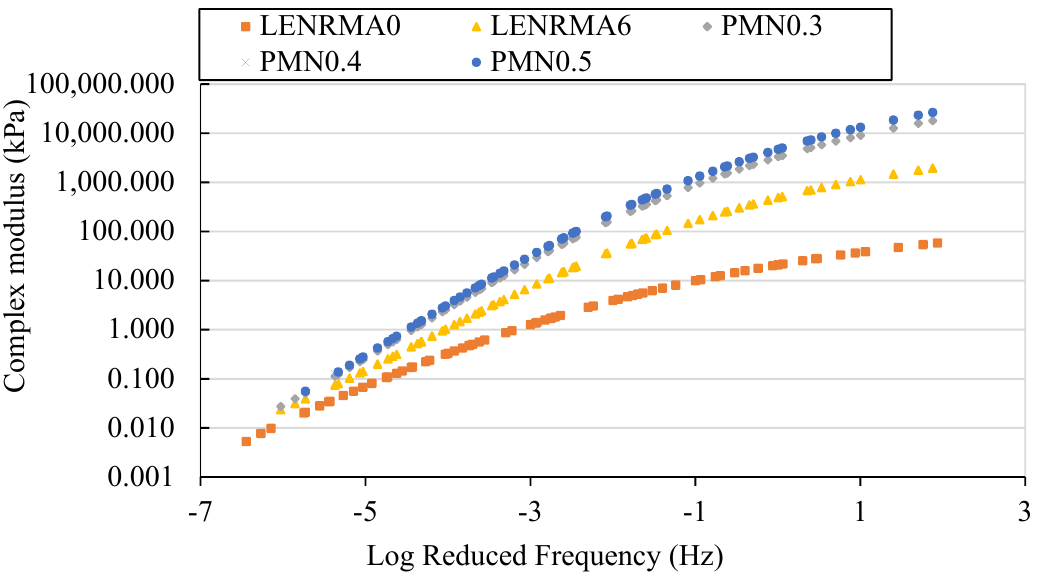
Figure 13. Complex modulus master curve for PMNs at a ref. temperature of 25 °C.